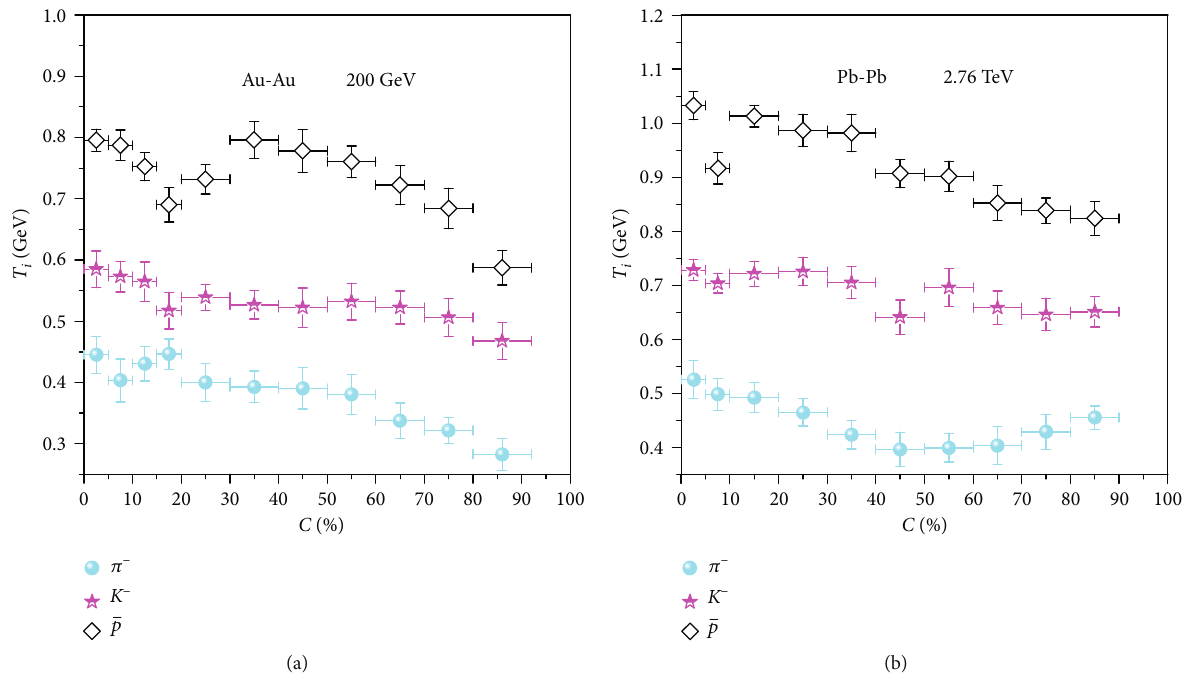
Figure 6: Same as Figure 3, but for dependence of the initial temperature T